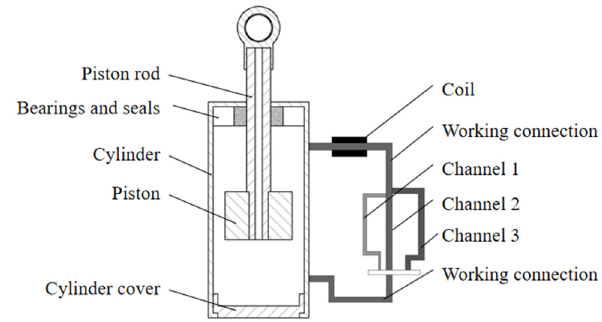
Figure 2. Single-ended single-tube multi-stage bypass